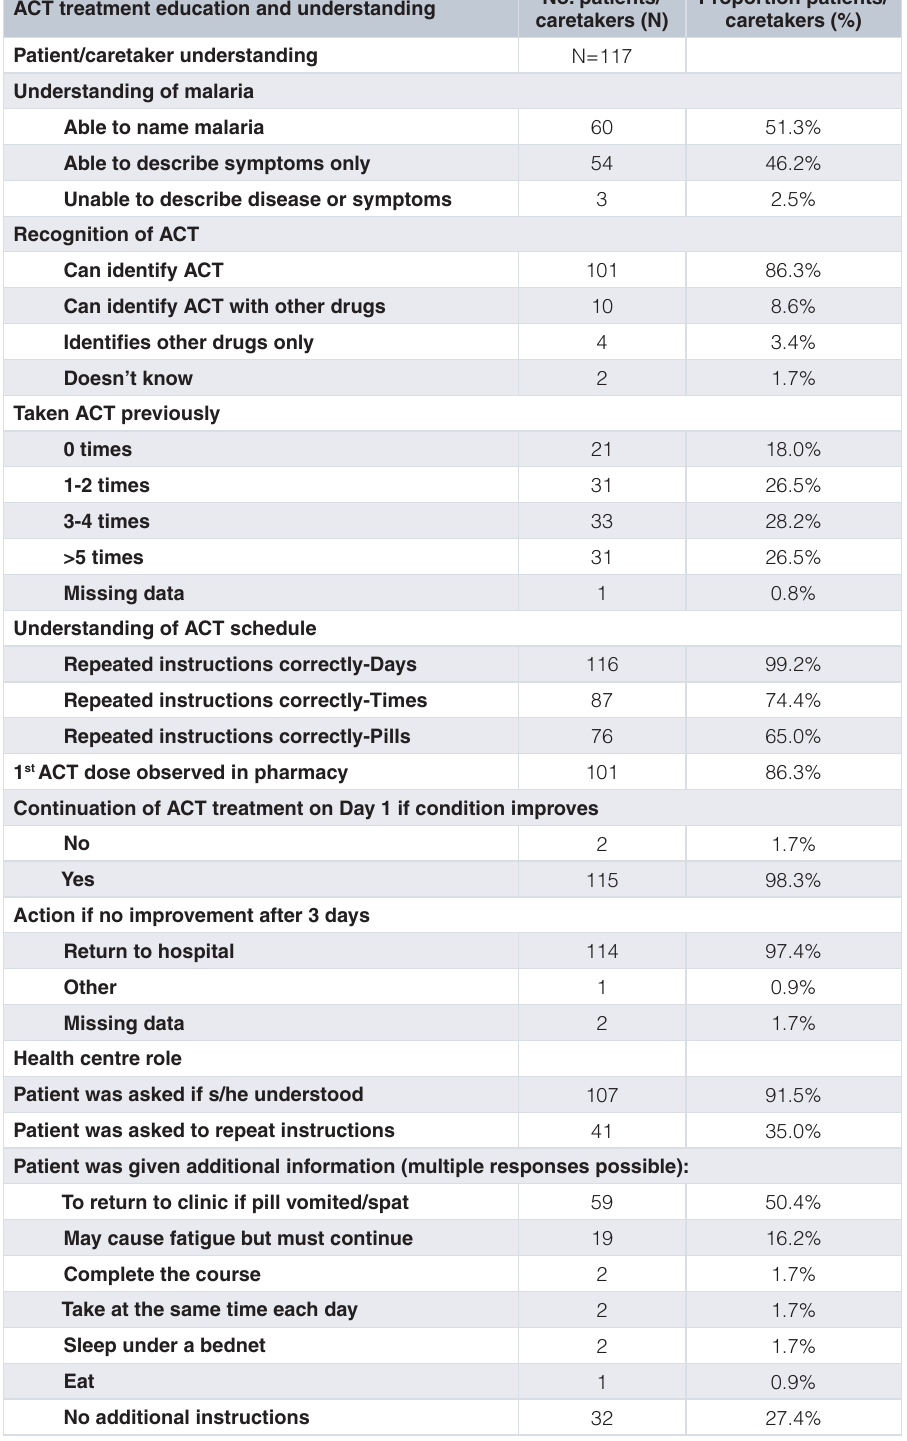
Table 12. ACT treatment education and understanding in the exit group. ACT treatment education and